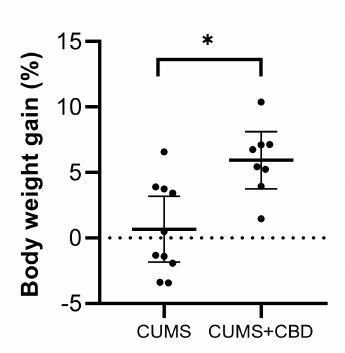
Figure 3. Results of body weight measurements during a four-week CUMS procedure with or without concomitant cannabidiol (10 mg / kg body weight) treatment. Data are expressed as mean ± 95% confidence interval; * p < 0.05 vs.